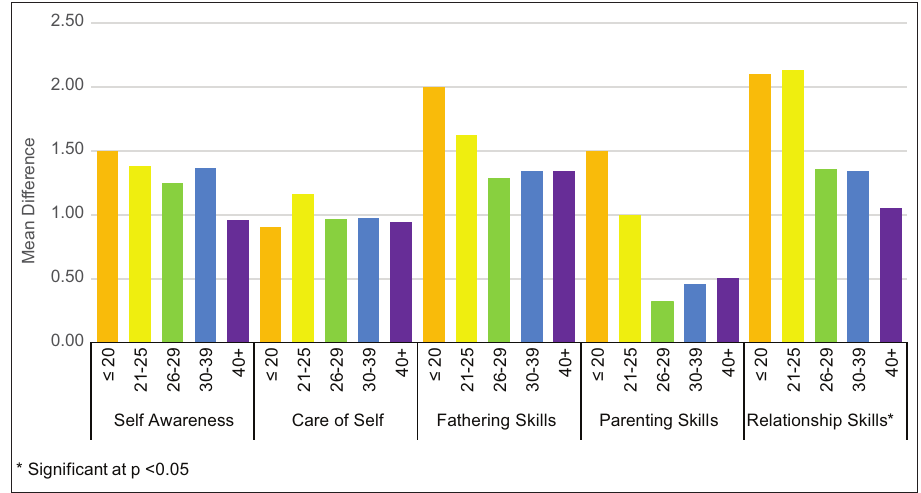
Figure 1 . Acquisition of fatherhood knowledge according to participant age and knowledge